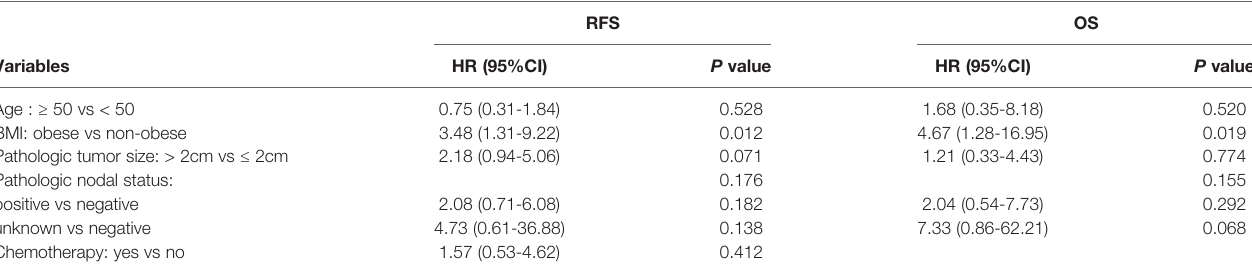
TABLE 4 | Multivariate analysis of factors associated with RFS and OS in luminal A